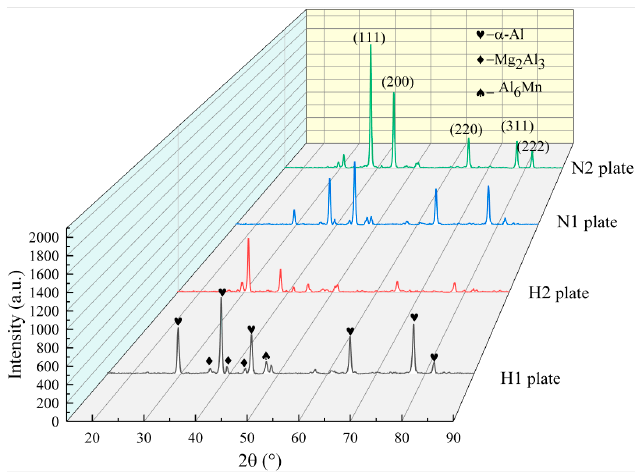
Figure 12. XRD patterns with a different state of 1561 aluminum alloy.